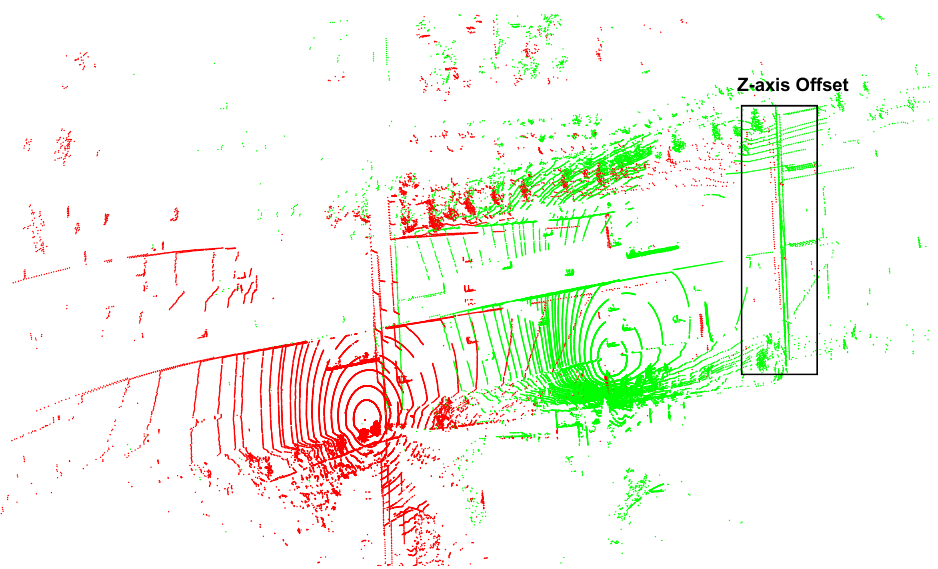
Figure 2. Example of z ‐ axis offset between two roadside LiDAR datasets.